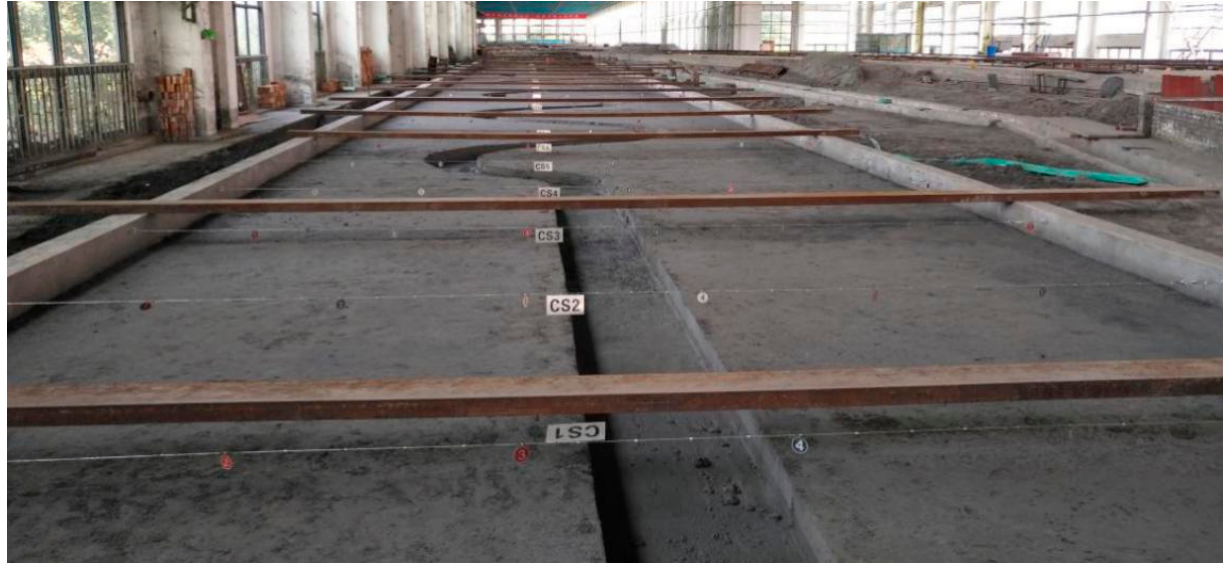
Figure 1. Panorama of the generalized water tank model. The experiment considered the vegetation arrangement in five cases: (1) a curved compound channel with non-vegetation on the beach, (2) curved compound channel with vegetation on the convex bank of the beach, (3) curved compound channel with vegetation on the concave bank of the beach, (4) curved compound channel with vegetation on both sides of the beach, and (5) curved compound channel full of vegetation on the beach. Disposable chopsticks (22.5 cm in length and 5 mm in diameter) were used to simulate vegetation. The planting height of the floodplain vegetation was 7 cm, and the diameter was 5 mm. Concerning the vegetation layout cases (1)–(4): the horizontal distance between the vegetation and the main trough was 10 cm, the vertical distance between the vegetation was 4 cm and the velocity measurement sections were CS6 and 8 (curved compound channel with non-vegetation on the beach), CS10 and 12 (curved compound channel with vegetation on the convex bank of the beach), CS14 and 16 (curved compound channel with vegetation on the concave bank of the beach), and CS18 and 20 (curved compound channel with vegetation on both sides of the beach). For case (5): the horizontal and vertical distances between vegetation were 10 cm, and the velocity measurement sections were CS22 and CS24 (Figure